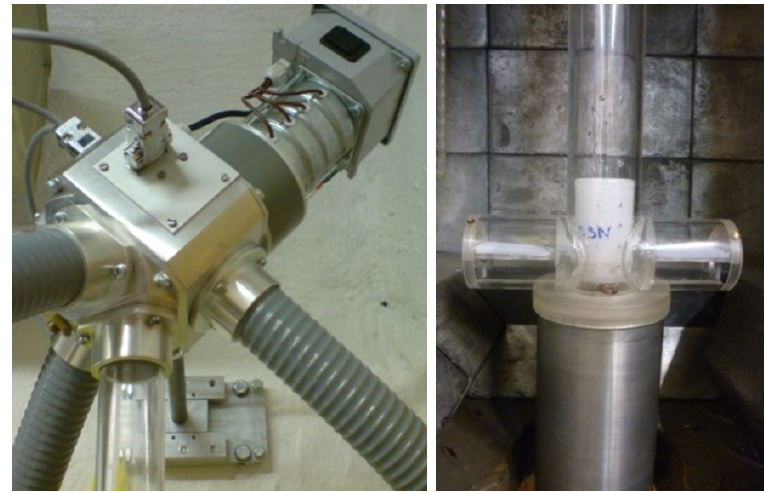
Figure 2. Components of the pneumatic tube delivery system installed at the MT-25 microtron. Left : 4-way routing head installed above the detector shielding with positions for sample insertion and delivery to the irradiation terminal (and back), counting position, and discarding position. Right : Sample in irradiation vial at the counting position on the detector inside the shielding.